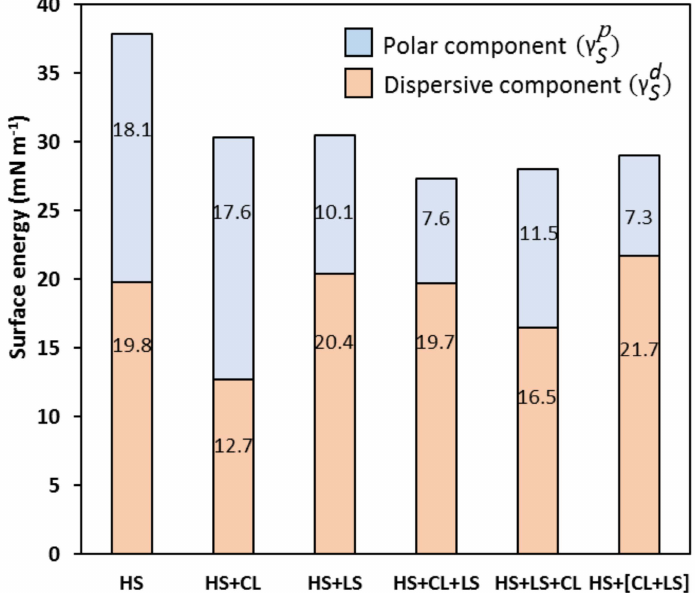
Figure 6. Calculated surface energy and its dispersive and polar components for lignin-free reference (HS) and single-layer coated handsheets (HS + CL; HS + LS) in comparison to two-step coating variants involving sequential deposition of cationic lignin and lignosulphonate with intermediate drying (HS + CL + LS); the reverse order of deposition with (HS + LS + CL) and without intermediate drying (HS + [CL +